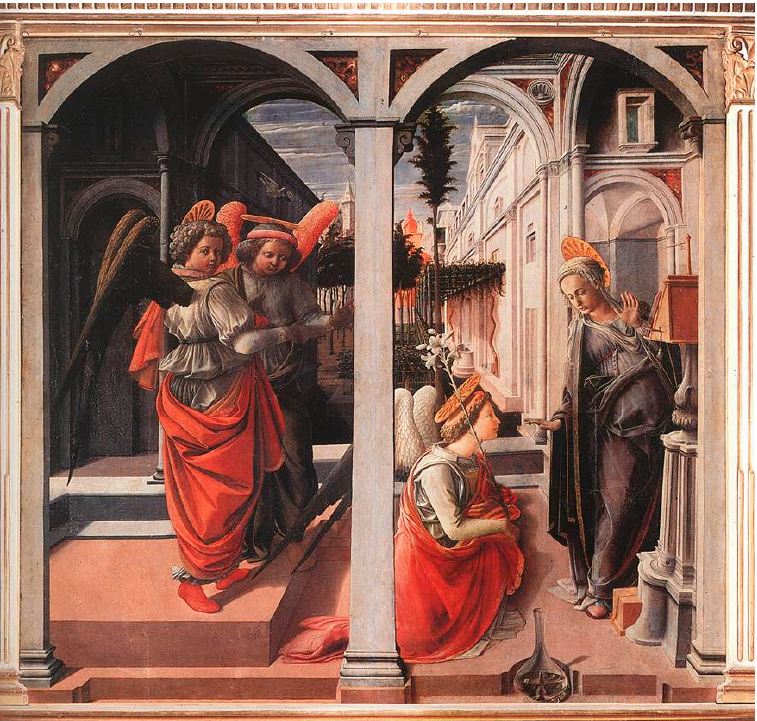
Figure 6. Stefan Lochner, The Annunciation , two panels of the closed Magi Altarpiece , Cologne cathe- dral, 1440.